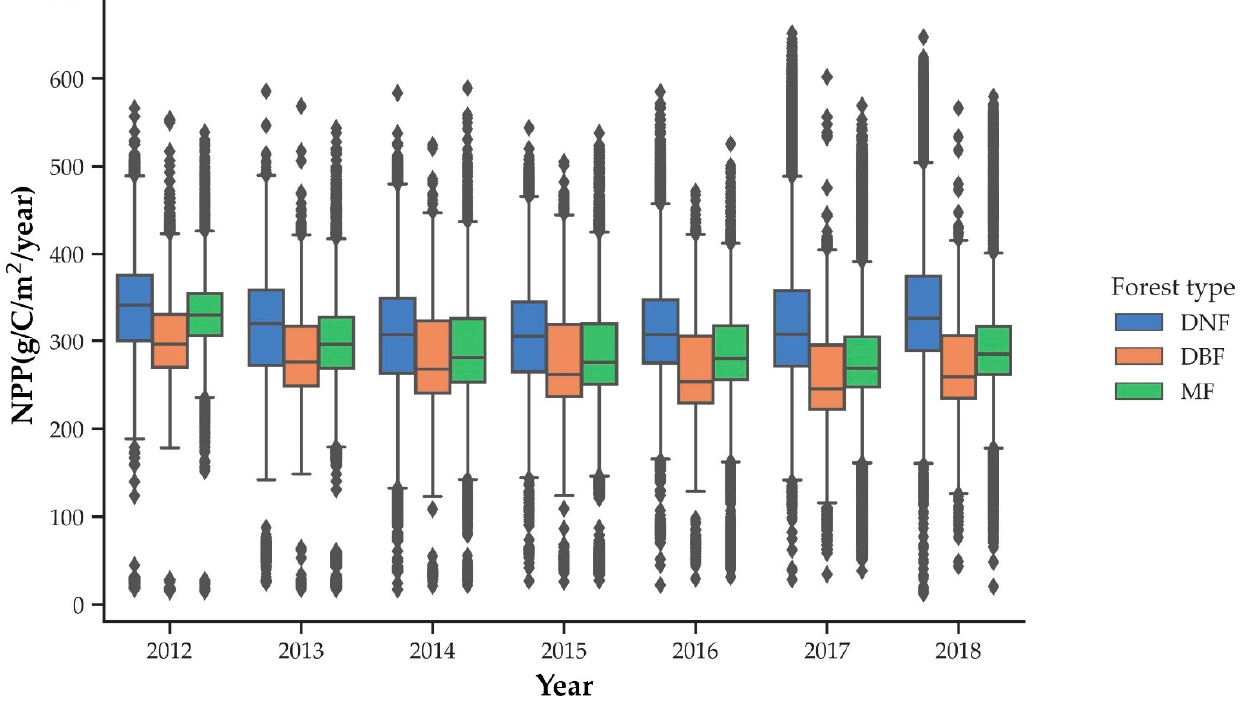
Figure 8. The distribution of different forest types in growing season NPP from 2012 to 2018.